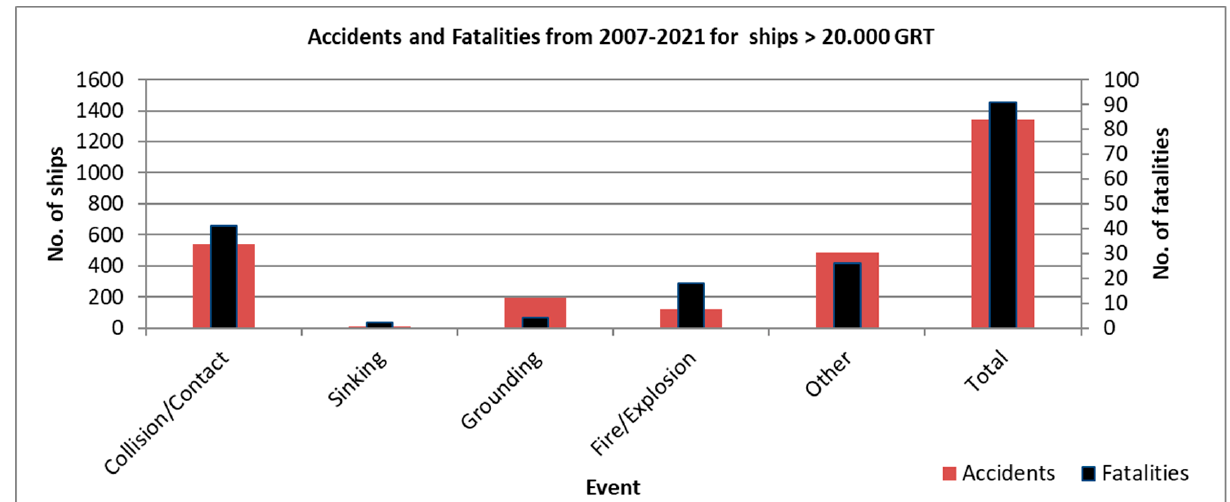
Figure 3. Tanker accidents from 2007–2021.